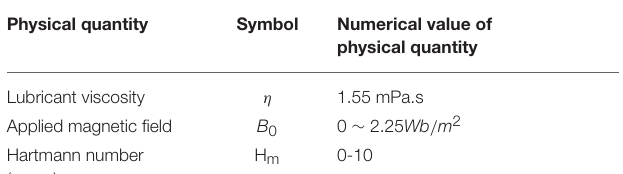
TABLE 2 | Numerical data for present study. (a) Lubricant rheological properties (Lin, 2010; Daliri et al., 2015) Physical quantity